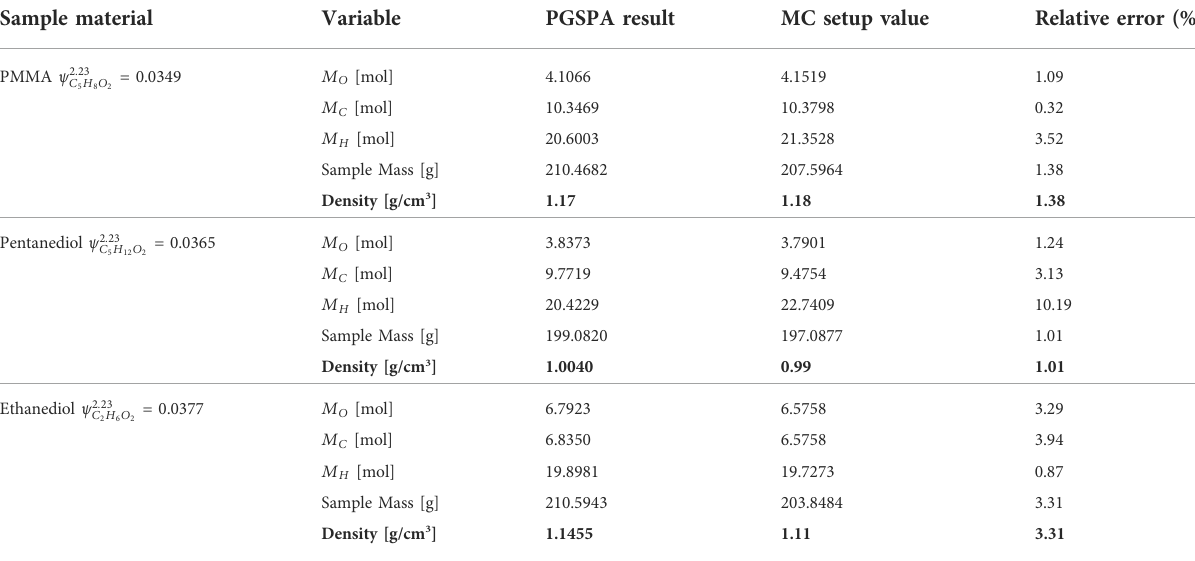
TABLE 8 Numeric solutions of M H and